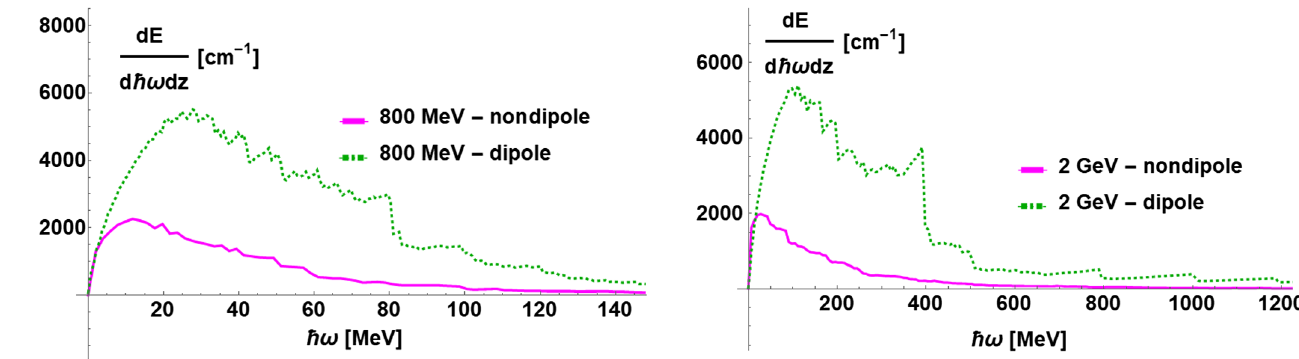
FIG. 4. Comparison of CR spectra calculated in the dipole and nondipole approximation for electrons of energy 800 MeVaxially channeled along the h 110 i axis of a 20 - μ m-thick W single crystal at parallel incidence with respect to the crystal axis.